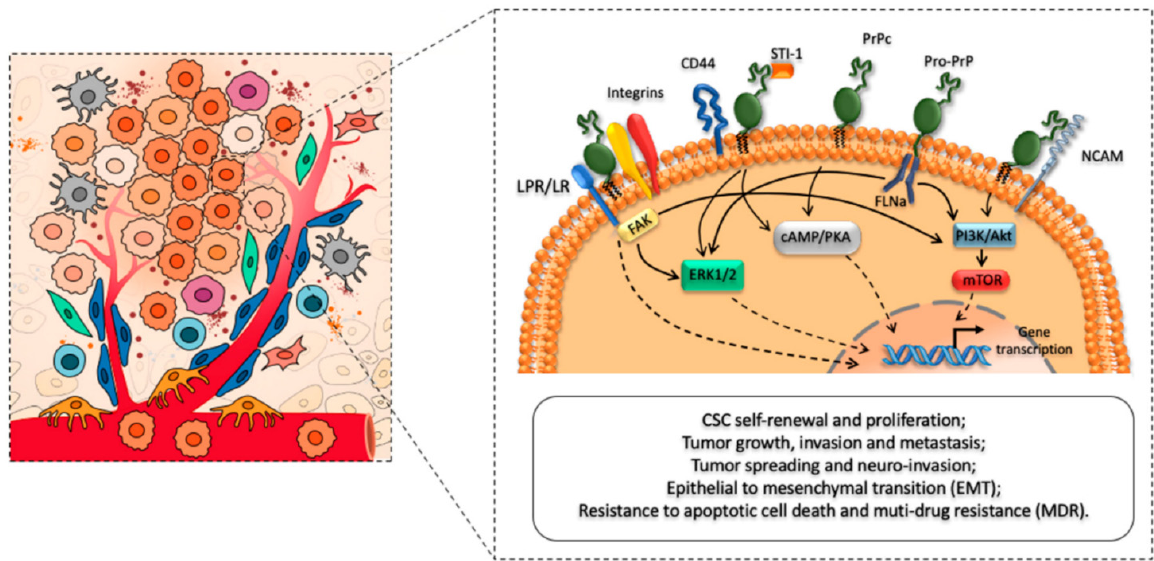
Figure 3. Schematic illustration of the regulatory role of PrP C in promoting cancer stem cells (CSCs) self-renewal, proliferation, and migration patterns. For a detailed description of CSCs phenotype, biology, functioning, and cross-talk between CSCs and major cellular components of the tumor micro-environment (TME), see Ref. [16]. Reprinted from Ref. [28] with permission under the terms and conditions of the Creative Commons Attribution (CC BY)